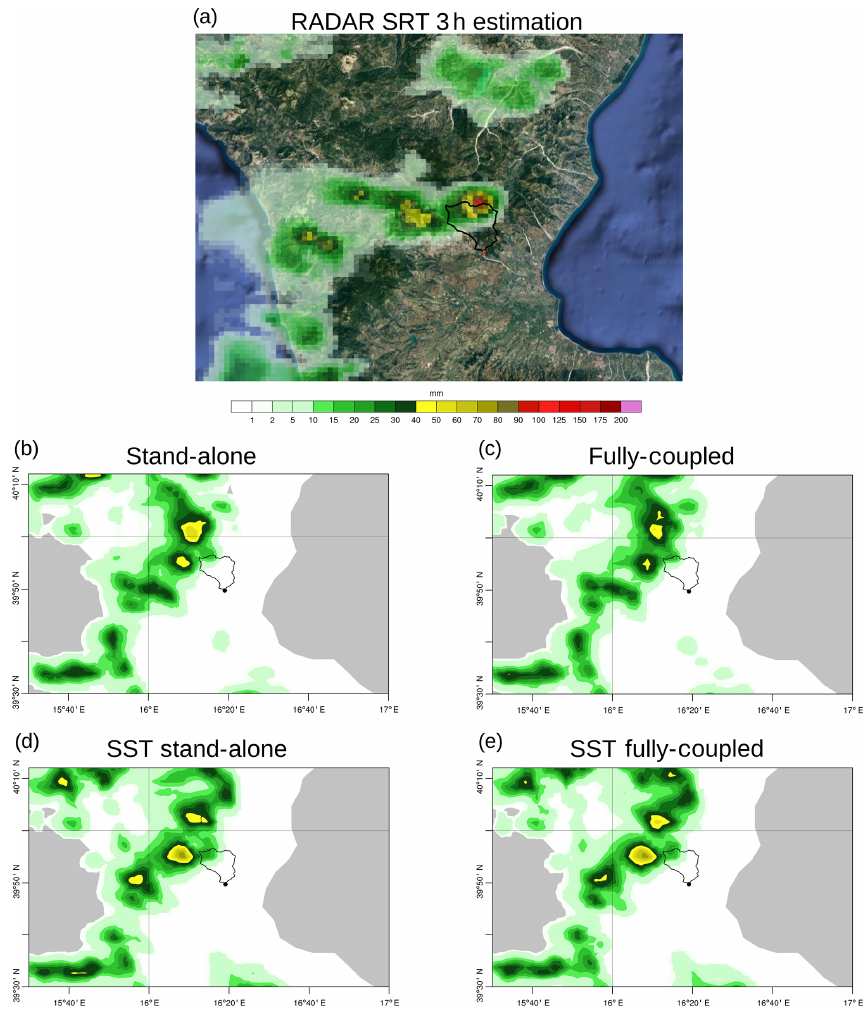
Figure 2. (a) The 3h (10:00–13:00UTC) surface rainfall total (SRT) product derived by radar, provided by the Regional Agency for the Protection of the Environment of the Calabria region (source: CFD, 2018); the map was slightly modified adding the contours of the catchment and the point of the disaster site (red dot); (b) 3h (10:00–13:00UTC) accumulated precipitation simulated by WRF for the run RUN_SA; (c) as in (b) for the run RUN_FC; (d) as in (b) for the run RUN_SST_SA; (e) as in (b) for the run RUN_SST_FC. The same colour bar is used for all the maps. In panels (b) to (e) the disaster site is identified by a black